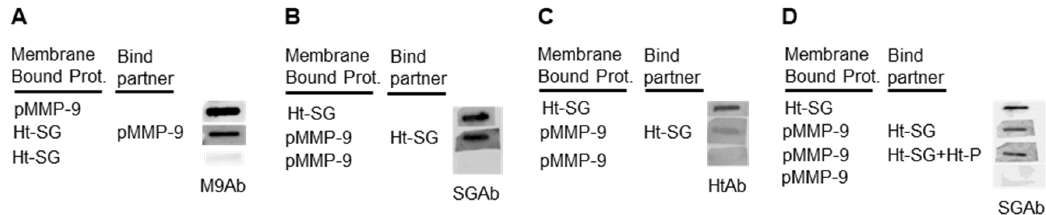
Figure 4. ProMMP-9 · Ht-SG complex formation. Fifty nanograms of pMMP-9 and 200 ng Ht-SG were added to a polyvinyl membrane using a slot-blot apparatus as described in the Methods. Briefly, the membranes were thereafter washed in TBST, incubated in blocking bu ff er containing milk powder (BB) for 1 h. Membranes with added pMMP-9 and Ht-SG were cut out, and membrane pieces containing bound pMMP-9 were incubated with either blocking bu ff er (BB), 5 ng / µ L (0.29 µ M) Ht-SG (in BB), or 0.29 µ M Ht-SG containing 0.87 µ M His-tagged peptide (Ht-P). Membrane pieces with bound Ht-SG were incubated with either BB or 50 ng / µ L pMMP-9 (in BB) for 2.5 h at room temperature. After washing three times with TBST, the membrane pieces were incubated for 24 h at 4 ◦ C with either antibodies against proMMP-9 ( A ), serglycin ( B , D ), or serglycin His-tag (Ht Ab) ( C ). The various membranes were thereafter washed with TBST, incubated with HRP-conjugated secondary antibody, washed with TBST, and subjected to antibody detection by the Luminol reagent and the Fujifilm LAS-4000 system. Each slot under A, B, C, and D, respectively, was from the same exposure time and exposed to the CCD camera at the same